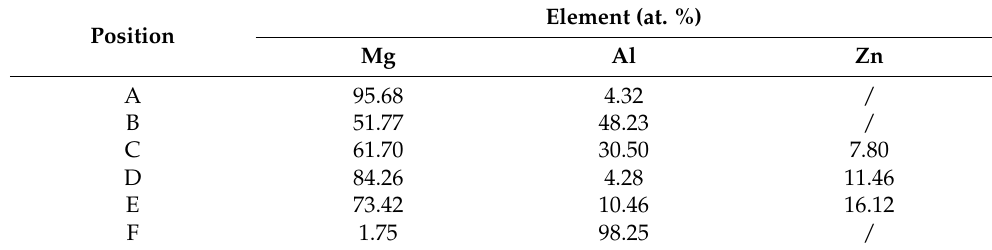
Table 3. EDS analysis results of positions marked in Figure